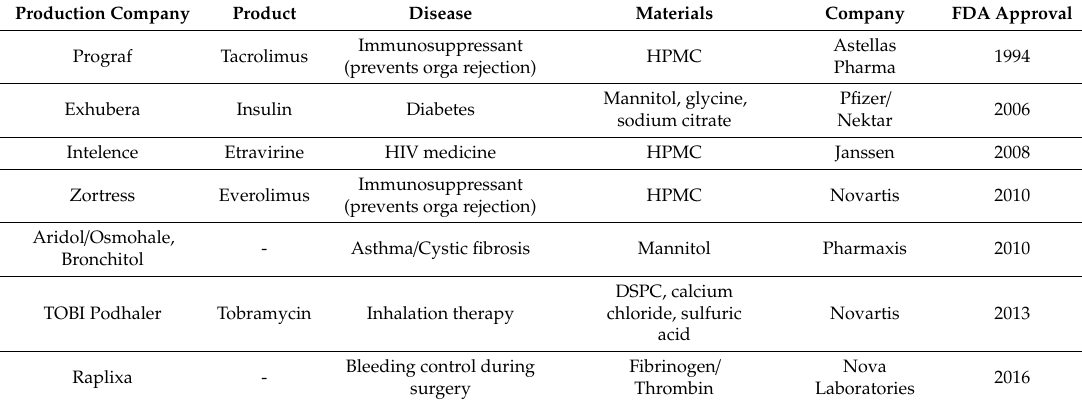
Table 2. Examples of FDA-approved medicine using nanospray drying technology as a preparation method